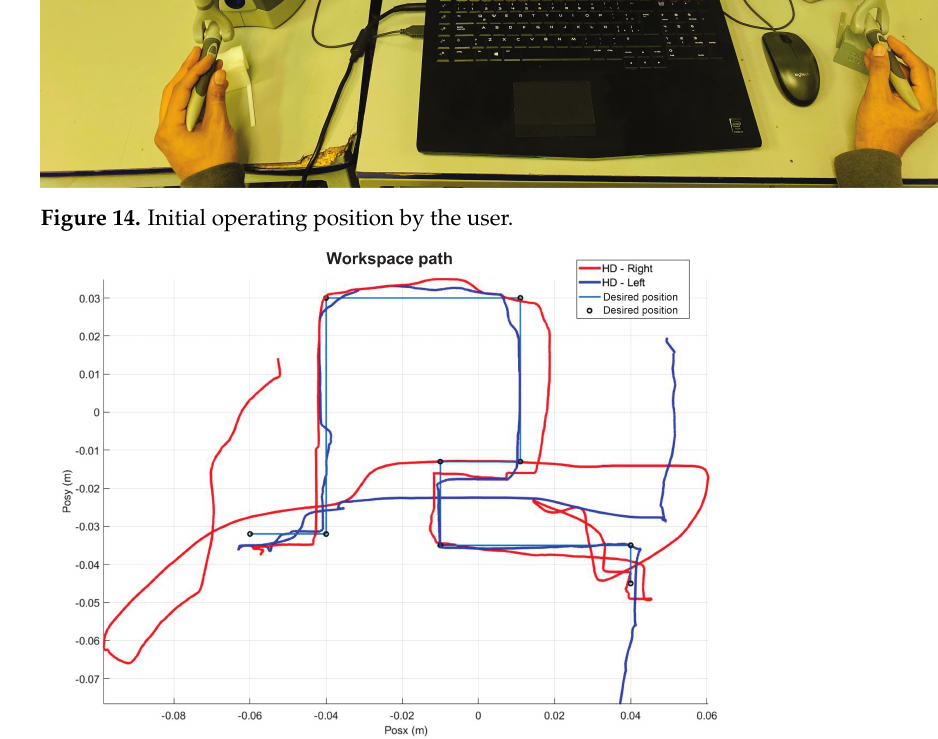
Figure 15. Workspace trajectory of two haptic devices in an active haptic guidance task for